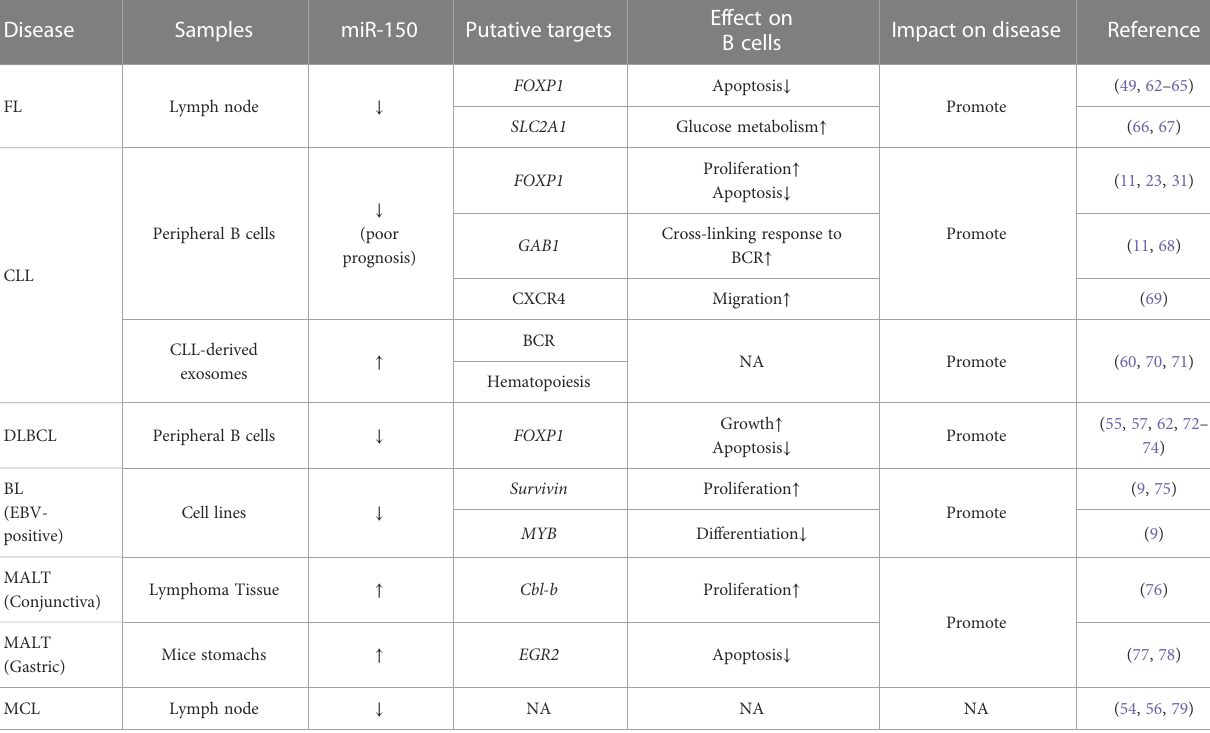
TABLE 1 The effects of miR-150 on B lymphocytes malignant tumors.